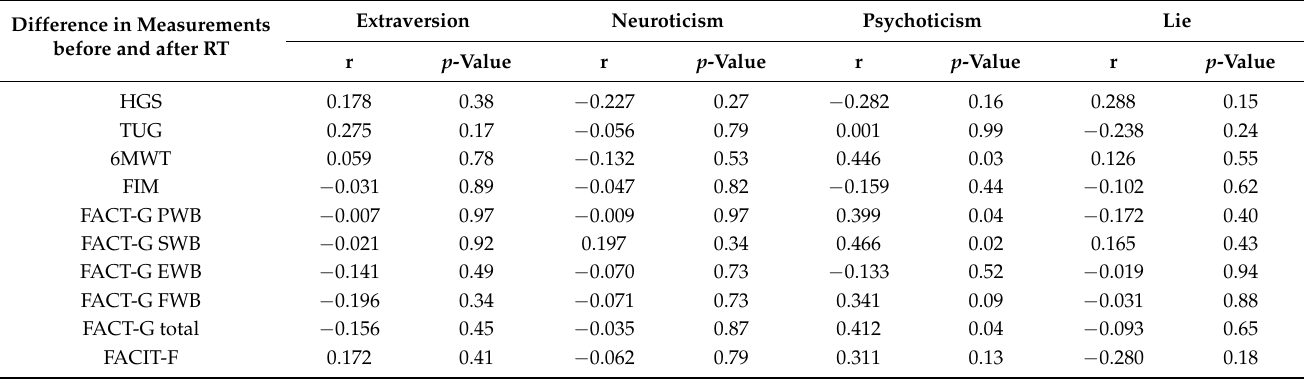
Table 7. Correlations between differences in outcomes before and after RT and personality traits.